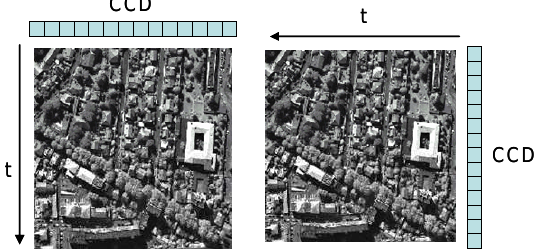
Figure 7: images obtained from geometric